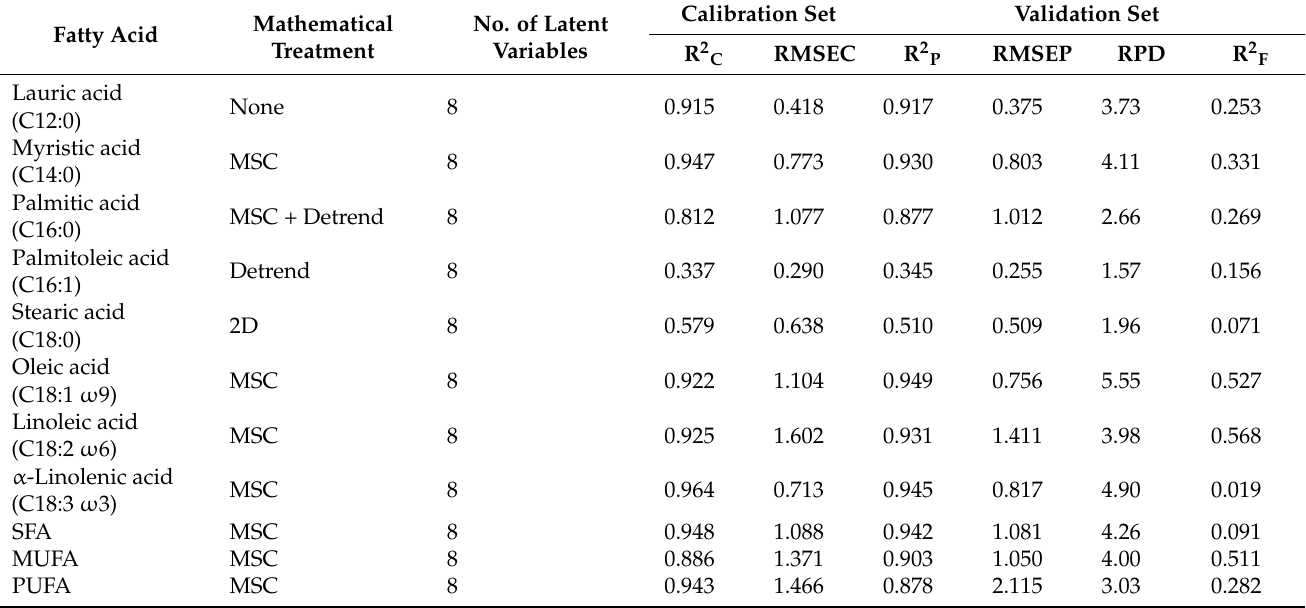
Table 7. Statistics of NIR prediction models for fatty acid content in living mealworm larvae.